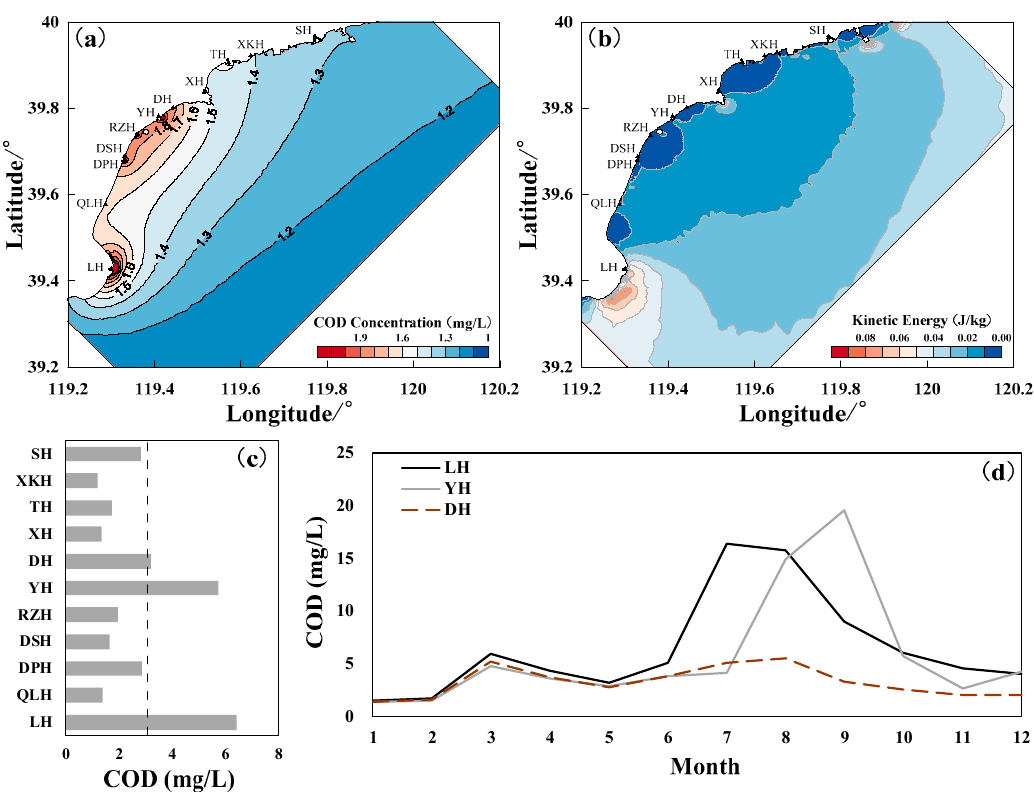
Figure 7. ( a ) The spatial distribution of annual average COD concentration in 2013; ( b ) the spatial distribution of annual average kinetic energy; ( c ) the annual average COD concentrations in 11 estuaries in QHD sea; ( d ) variations of COD concentrations in LH, YH, and DH estuaries where annual mean COD concentration exceeds 3 mg/L.